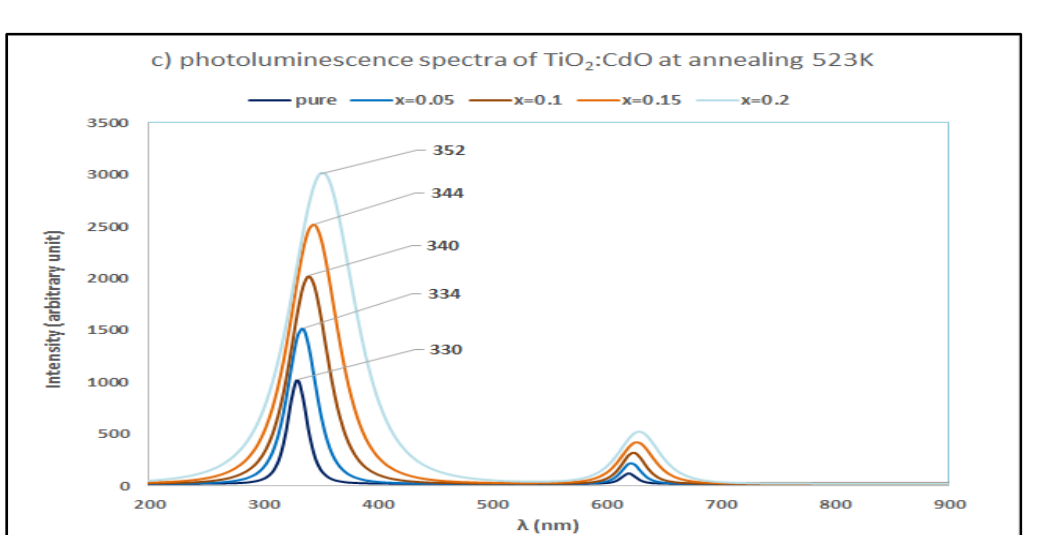
Fig. 3: Photoluminescence spectra for TiO